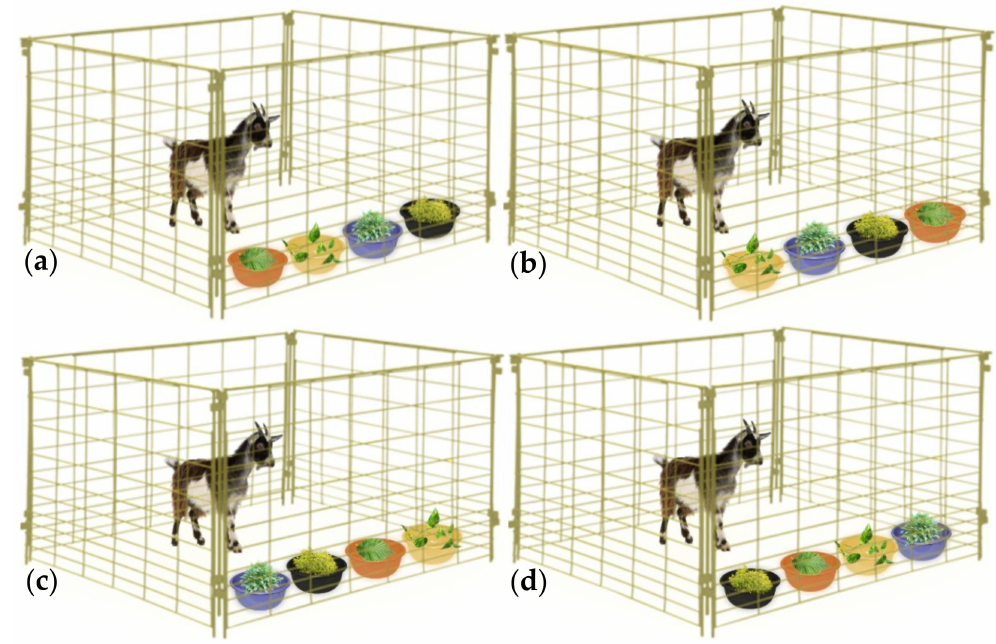
Figure 4. On-station trial for the evaluation of in-vivo anthelmintic properties of plants. Usage of more than two plant species implies a more realistic scenario albeit bioactivity of a specific plant should be considered cautiously. ( a – d ) represent the first, second, third and fourth experimental days. Containers in which the plants are o ff ered must be equidistant and changed on a daily basis to avoid associate learning. Some researchers choose to hang experimental plants to simulate browsing ingestive behaviors. Such considerations should be in function of the facilities where trials are